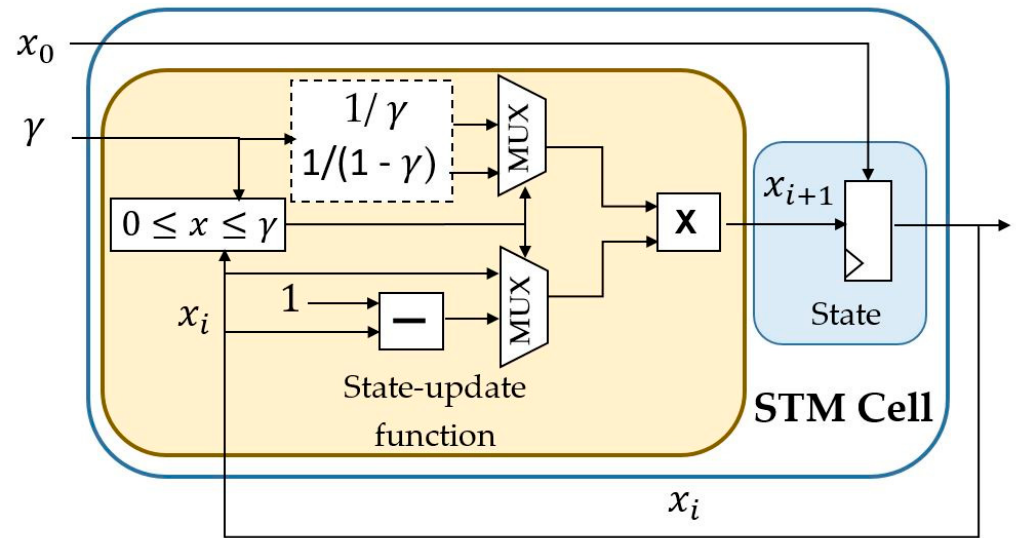
Figure 2. Block diagram of the skew tent map (STM) generator. Each state 𝑥 (cid:3036)(cid:2878)(cid:2869) is obtained as a function of the previous state 𝑥 (cid:3036) and the control parameter 𝛾 . For this purpose, the internal state 𝑥 (cid:3036) is compared to the value of 𝛾 to determine if it belongs to the (cid:4670)0,𝛾] range or to the (𝛾,1] range. In each case, by using two multiplexers, the correct factors ( 𝑥 (cid:3036) or ( 1 − 𝑥 (cid:3036) ) ) and ( 1/𝛾 or 1/(1 − 𝛾) ) are selected and multiplied.